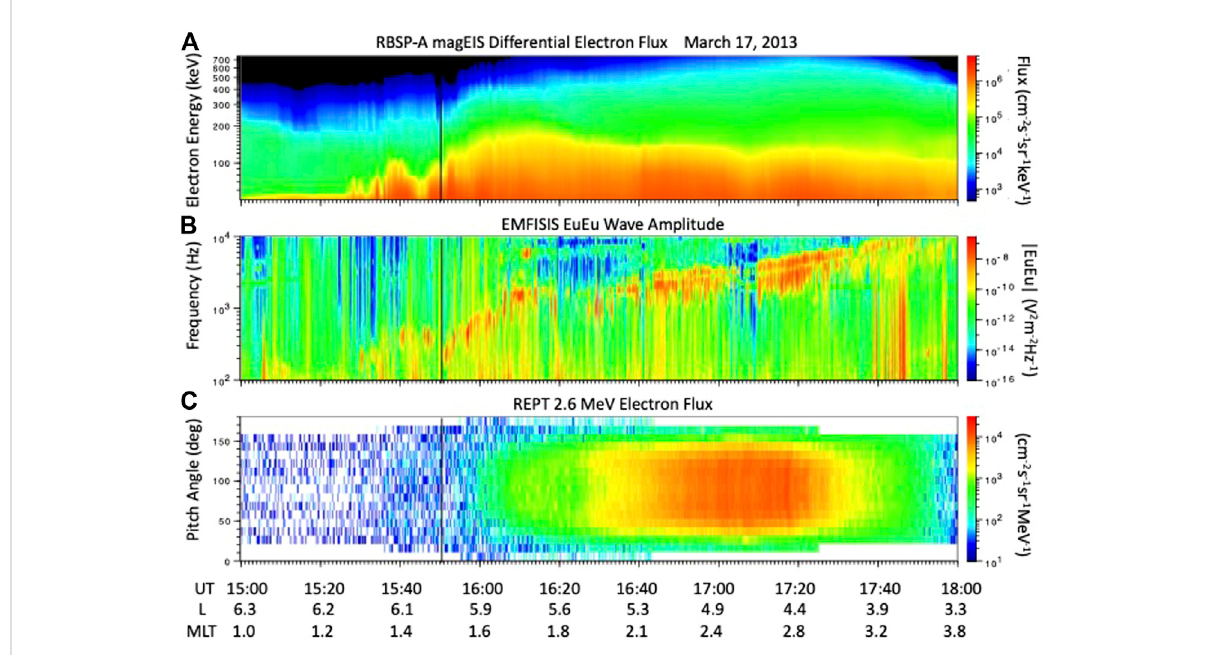
FIGURE 1 RBSP-A in situ observations of the rapid recovery of MeV radiation belt electron fl uxes on 17 March 2013. The black line marks the spacecraft location (L ~ 6; 1.5 MLT) at 15:50 UT. (A) MagEIS spectogram of lower energy electron fl uxes associated with chorus wave growth. (B) EMFISIS WFR electric fi eld spectorgram showing the onset of strong VLF chorus waves. (C) Pitch angle dependence of REPT 2.6 MeV electron fl